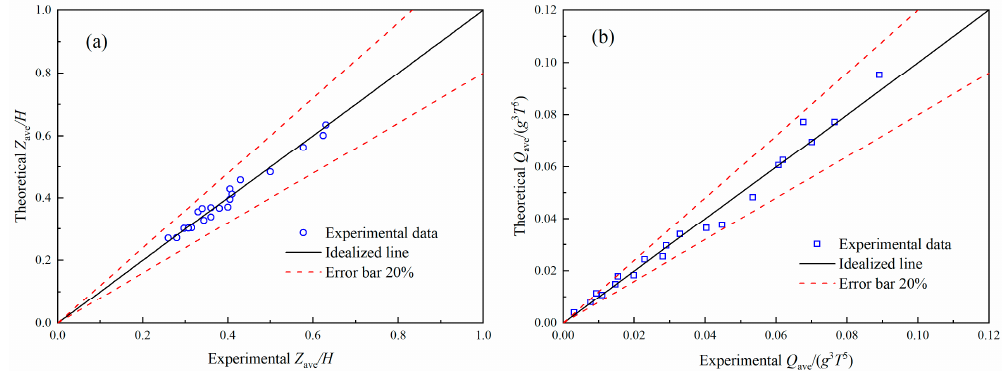
Figure 11. Validation of ( a ) Z ave / H and ( b ) Q ave / g 3 T 5 equations with experimental data.